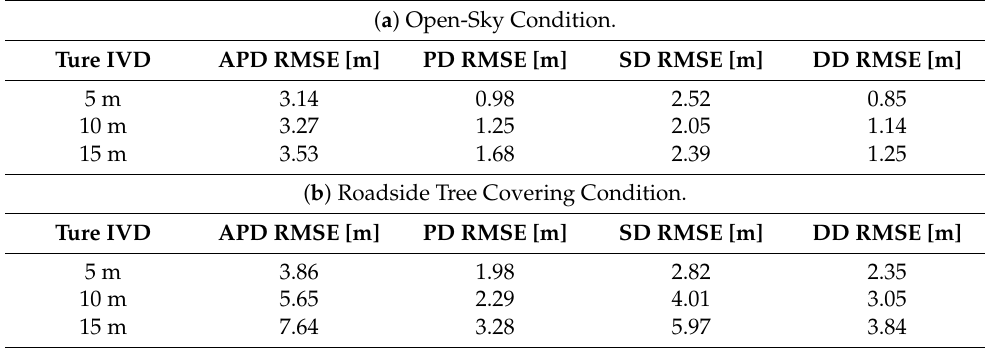
Table 3. The RMSE of all methods in dynamic experiment. ( a ) Open-Sky Condition.